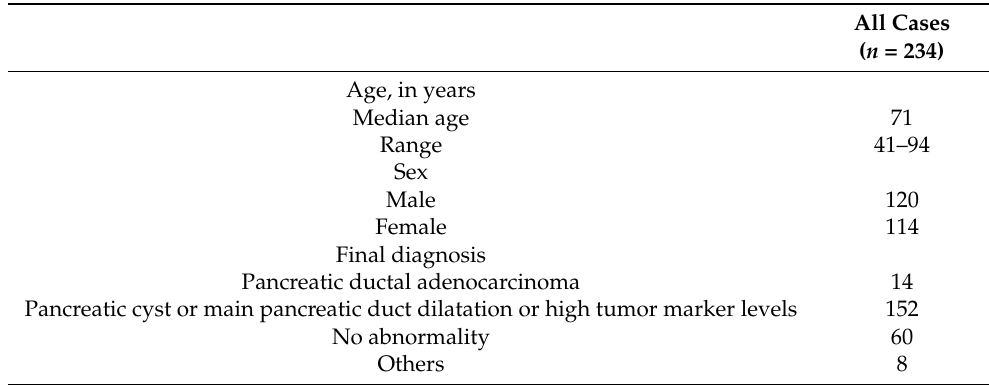
Table 1. Patient